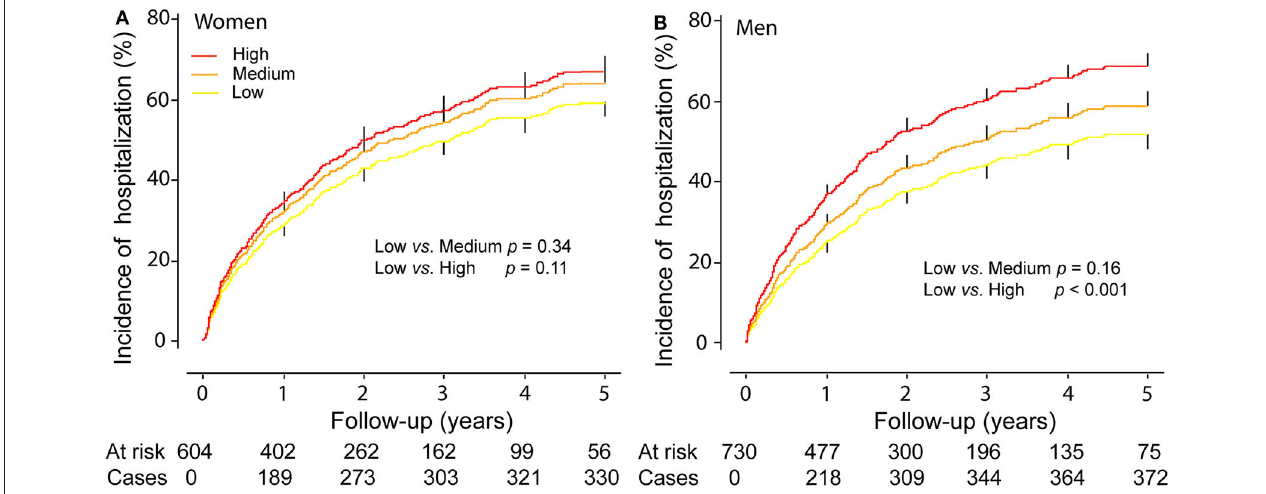
FIGURE 1 | Cumulative Incidence of any hospitalization in women (A) and men (B) by tertiles of the distribution of urine microalbumin/creatinine ratio. p -values refer to the differences between the low and the middle and the top tertiles of urine microalbumin/creatinine ratio distribution. Vertical lines denote the standard error.